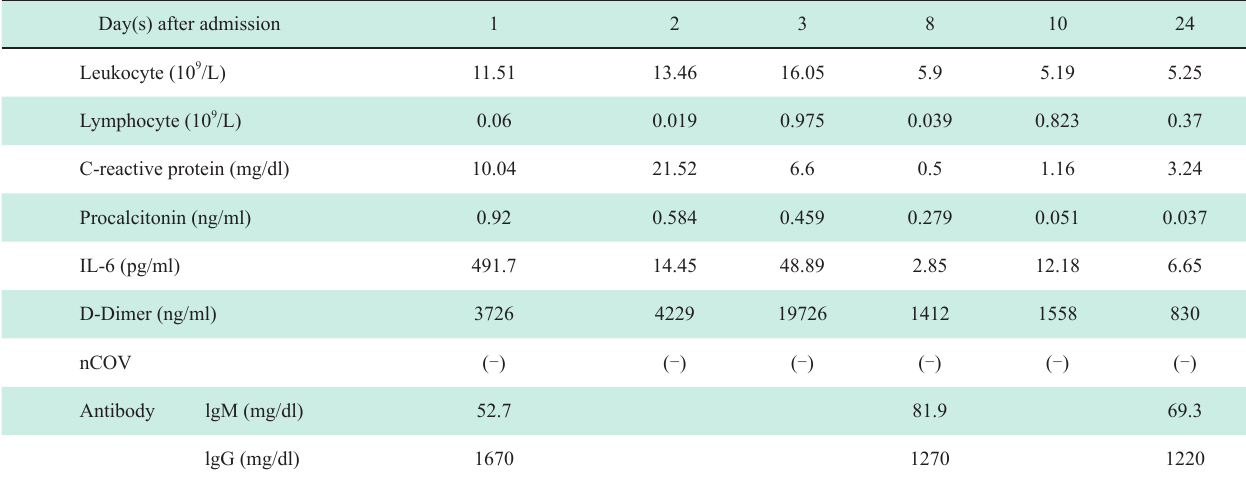
Figure 3 Plain CT scan of the lung. (A) Case 1, a -53-years old female patient; CT showed diffuse distribution of ground glass in both lungs on the day of admission; (B) Most of the ground glass density shadows disappeared 24 days after admission. Table 1 Laboratory results (part 1)